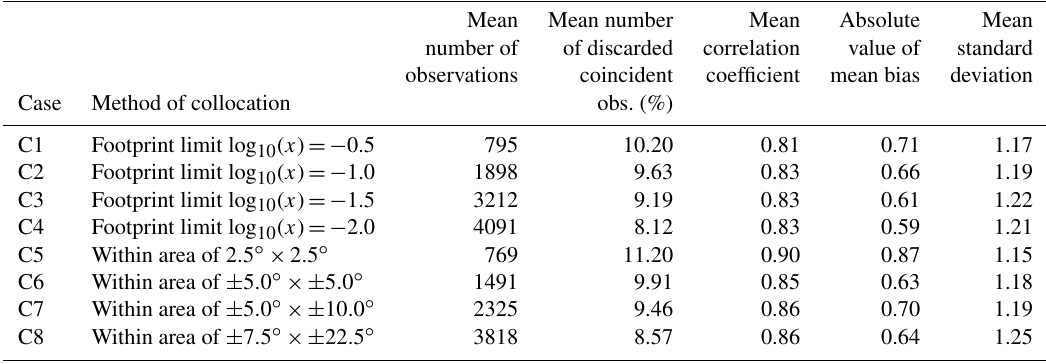
Table 7. Averaged results of different collocation methods implemented for XCO 2 from the GOSAT RemoTeC product calculated for 16 TCCON sites.